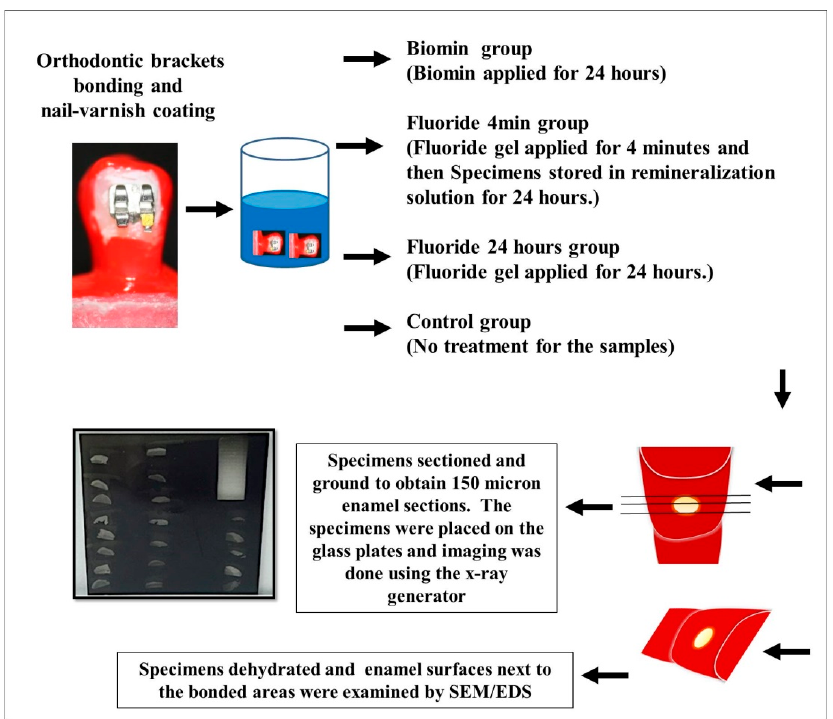
Figure 1. Samples preparation and examination.